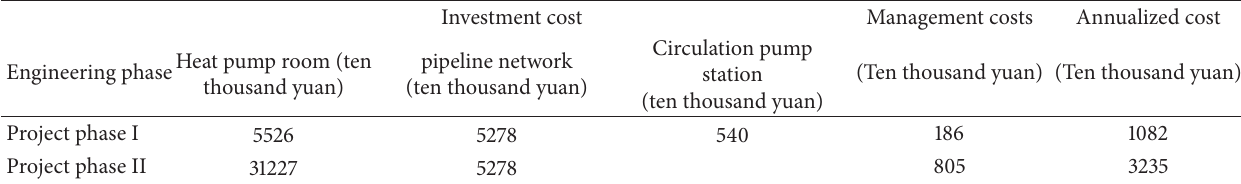
Table 2: Nonenergy costs of